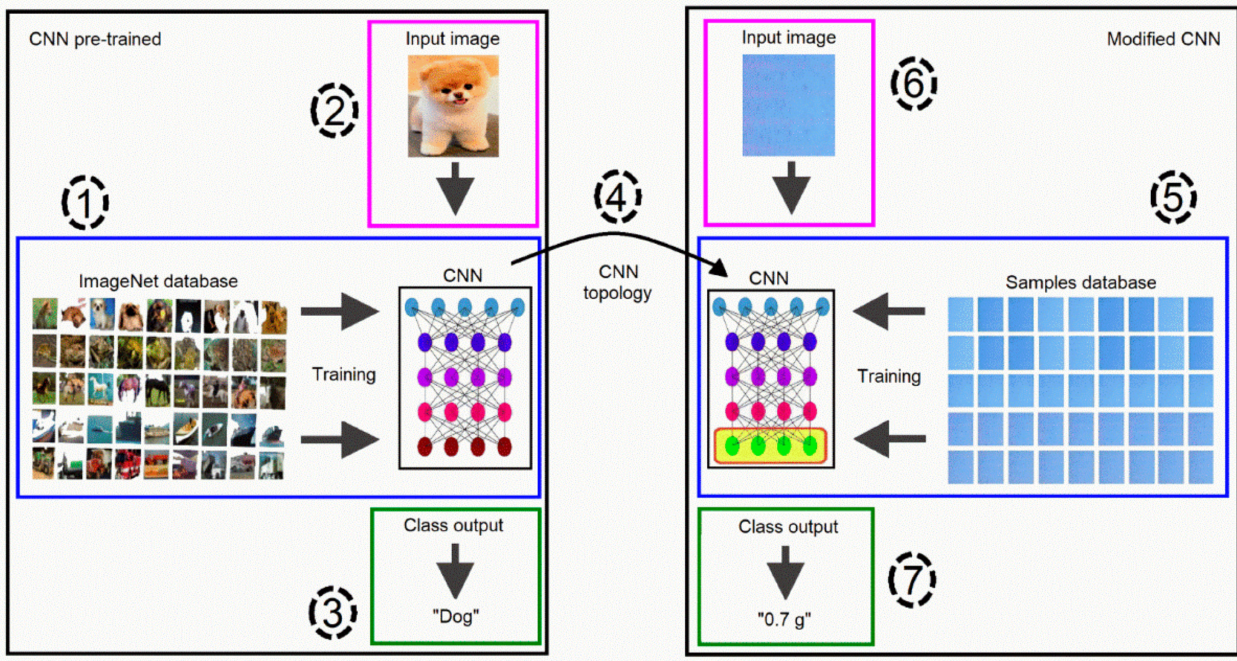
Figure 1. Representation of the TL process in the CNN model used: ( 1 ) training dataset (ImageNet) and CNN; ( 2 ) input image to classify; ( 3 ) classification result; ( 4 ) reuse of the pre-trained model for a new task; ( 5 ) new training dataset (images of the new task) and modification of the CNN; ( 6 ) new input image to be classified; and ( 7 ) classification